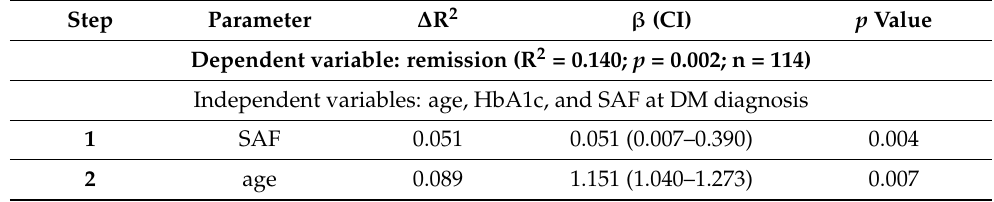
Table 5. Logistic regression of remission as dependent variable.